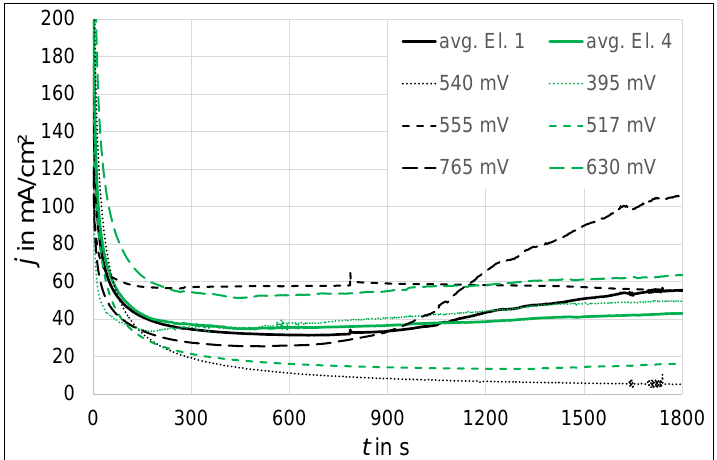
Figure 7. j – t curves due to polarization at constant OCP + 500 mV in electrolytes 1 and 4. The solid lines represent the averaged curves; the dashed lines represent the curves of the individual samples with the potentials of the individual measurements vs. SHE.